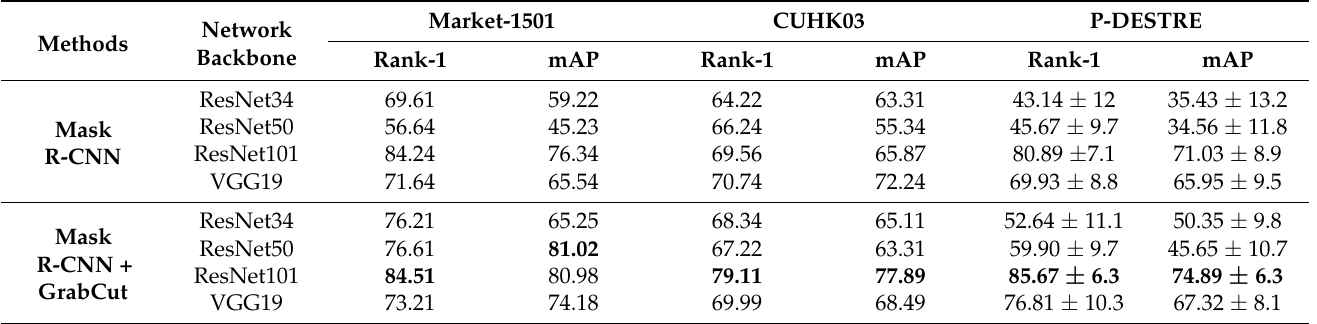
Table 2. Performance comparison of person Re-ID accuracy (%) using a different network backbone for Mask